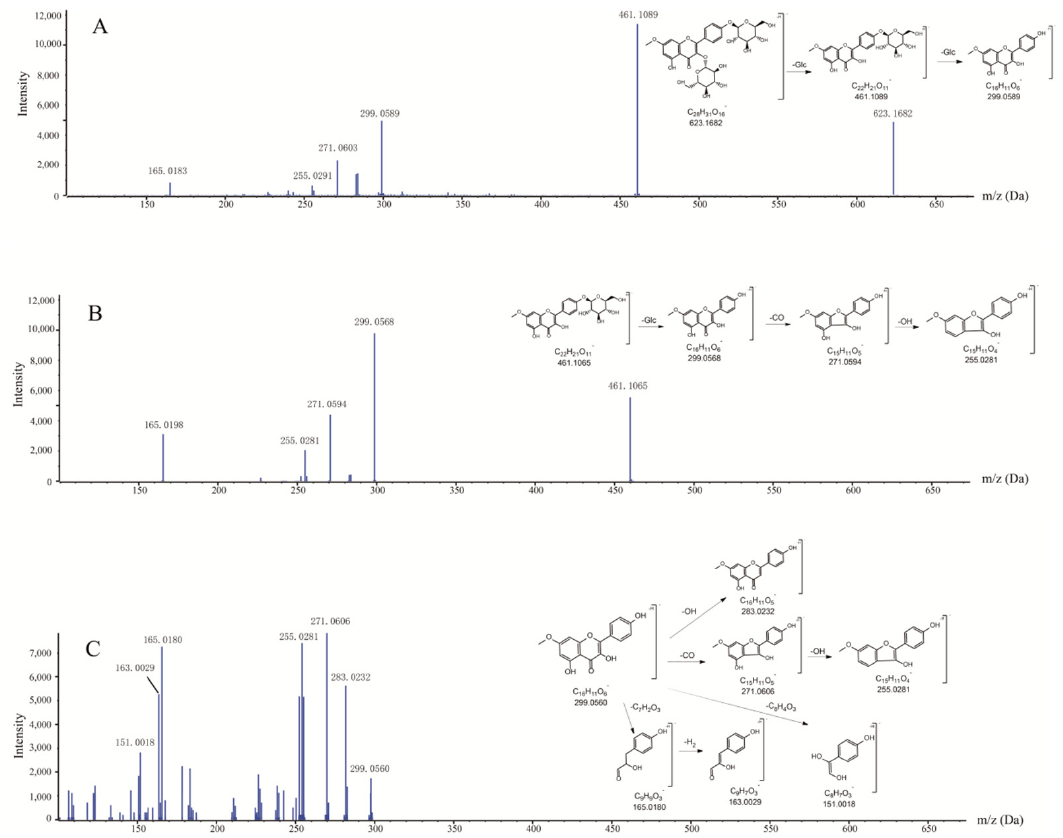
Figure 1. Proposed fragmentation pathways of complanatuside ( A ), RNG ( B ), and RNC ( C ).